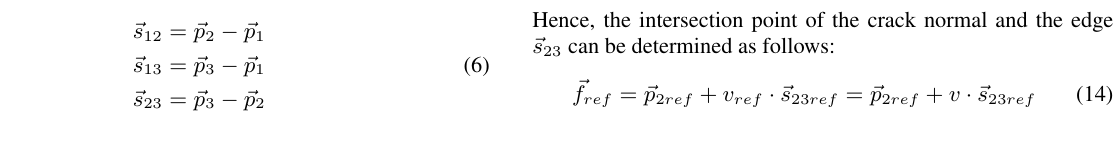
A line is defined by p 1 and the crack normal and is intersected with the edge s 12 . The difference of the distances between the intersection point f and p 1 and its corresponding value in the reference state is the crack width, see Figure 7.